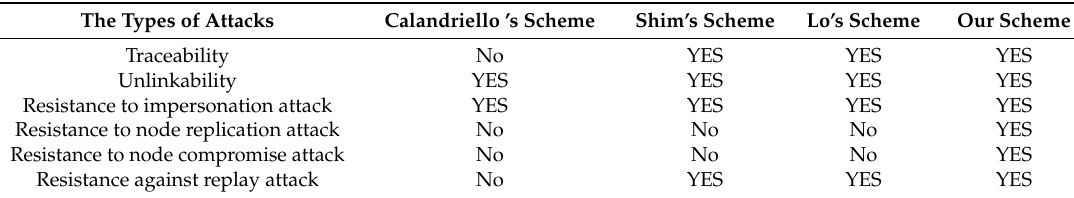
Table 2. Security Comparisons of Related Schemes and Our